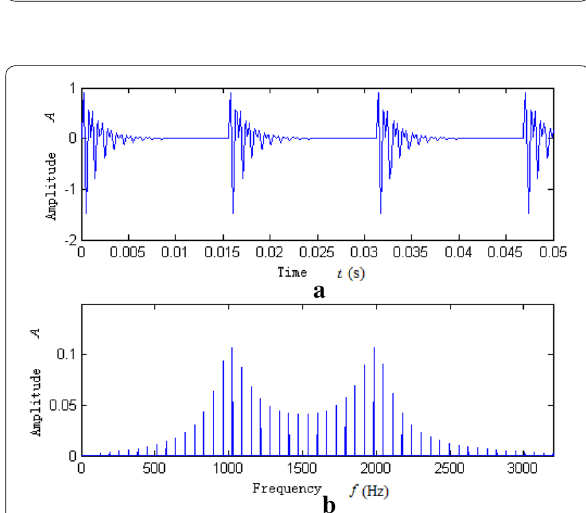
Figure 10 Superposition result under condition 2: ( a ) time waveform, ( b ) FFT spectrum